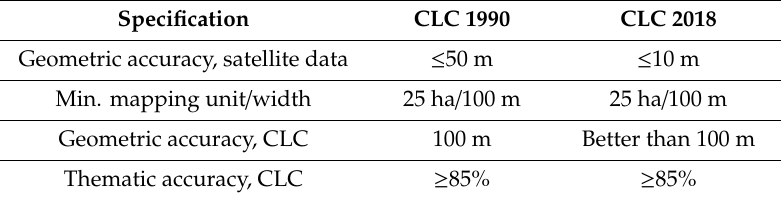
Table 1. The specifications of the CORINE land cover data in the reference years 1990 and